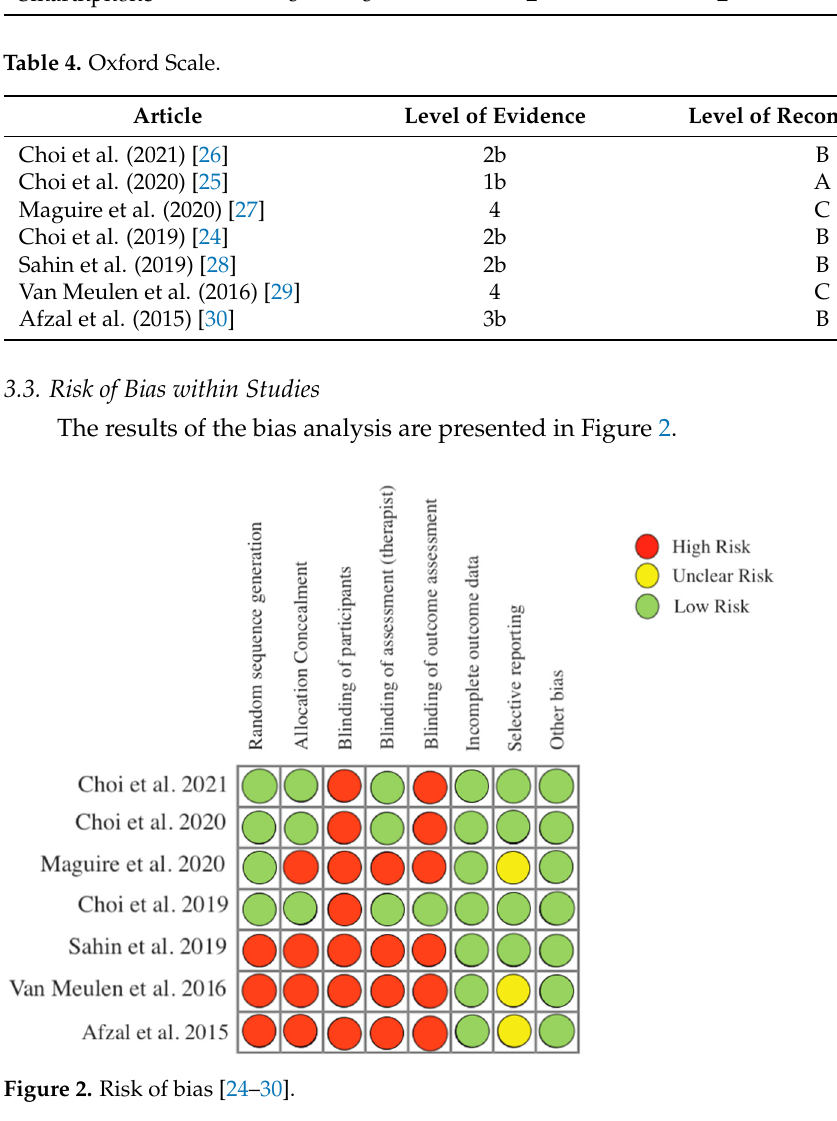
Figure 2. Risk of bias